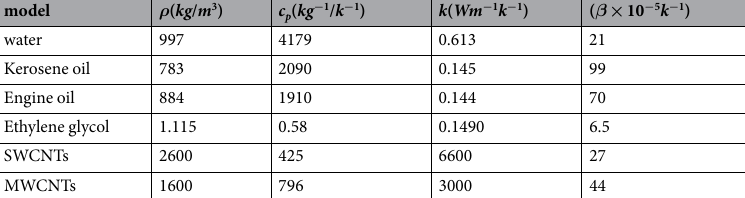
Table 1. Thermophysical properties of CNTs and different fluids.